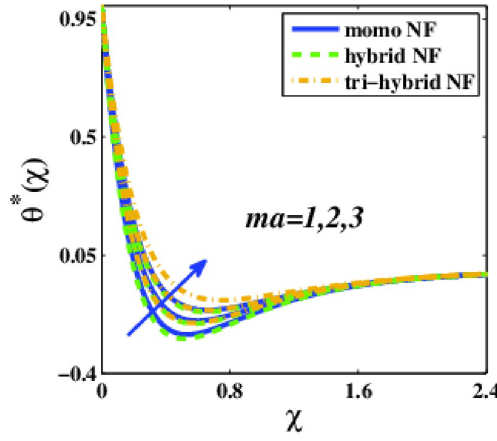
Figure 17. Control of ma on θ ∗ (χ) .